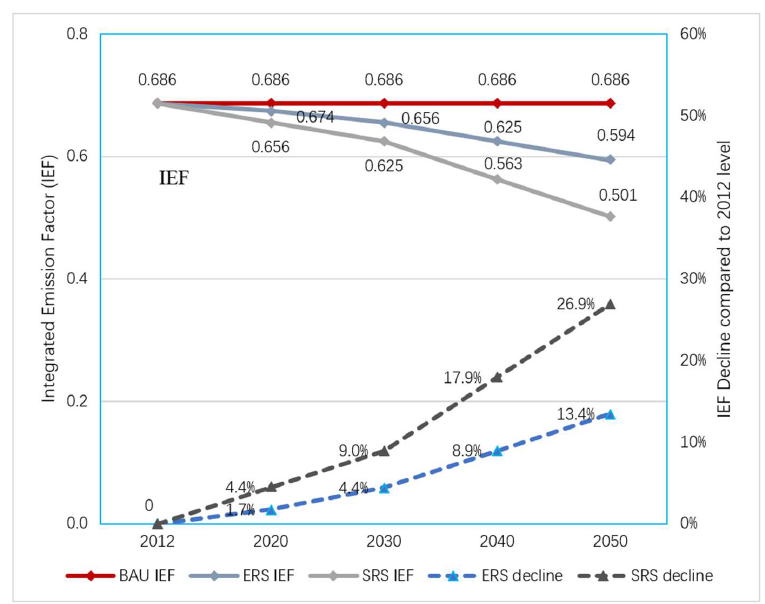
Figure 5. Implied emission factor and decline trend for each scenario.